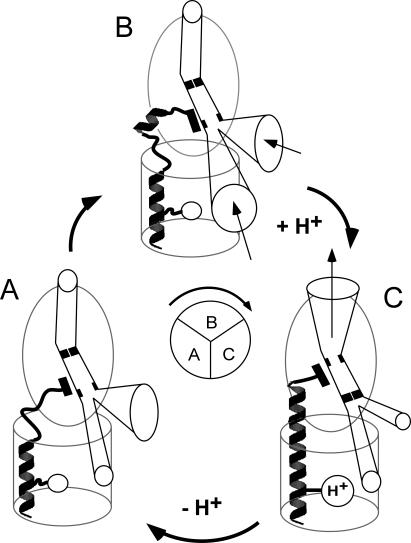
Schematic Drawing of the Transport Pathway of the AcrB Efflux Pump Suggesting a Rotary MechanismProposed mechanism: Substrate may bind into the channel through the open entrances of subunit B. Helix 8 is only weakly pronounced and mostly random coil. Changes of the protonation state of residues of the putative translocation site induce the formation of helix 8 and thus the closing of the channel entrances and the simultaneous opening of the gate, extending the channel to the central funnel at the top of the headpiece showing the conformation of subunit C. The bound substrate can be released into the central funnel from where it reaches TolC and finally the cell exterior. Deprotonation takes place, leading to the collapse of helix 8, and the channel goes back to the original conformation (subunit A).